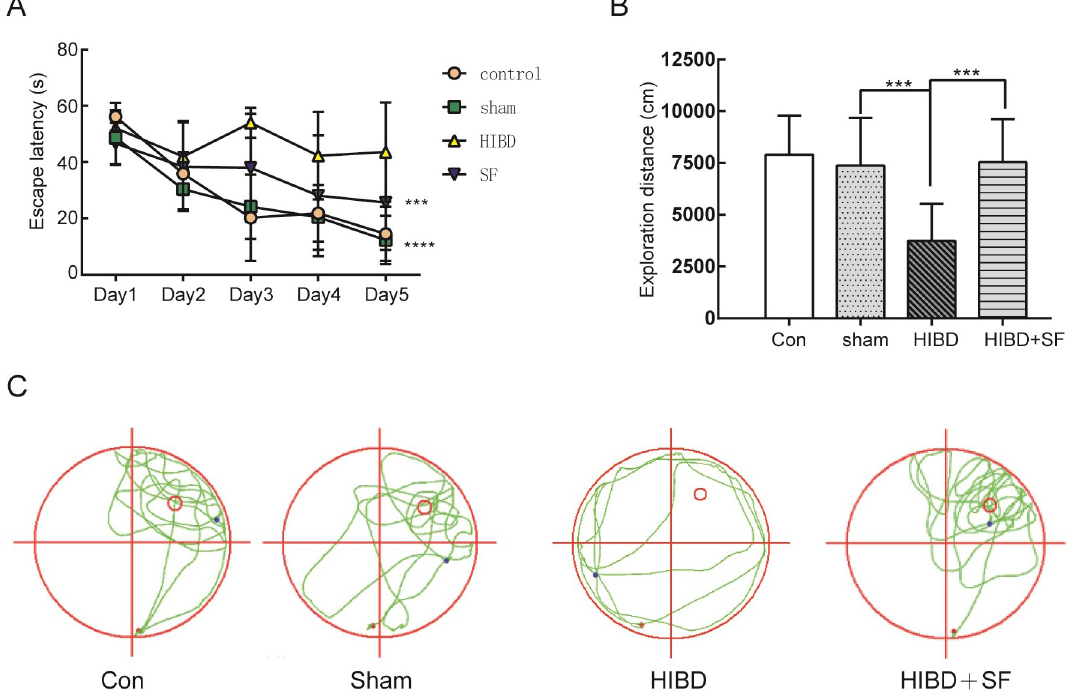
Fig 2. FA ameliorated learning and memory impairments in HIBD rats. (A) The escape latency (T value) of the rats in the training period. (B) The exploration distance (P value) of the rats in the exploratory trials. (C) The exploration route in the retention trial. ���� P < 0.0001, ��� P < 0.001. N = 10 for Morris water maze analysis.